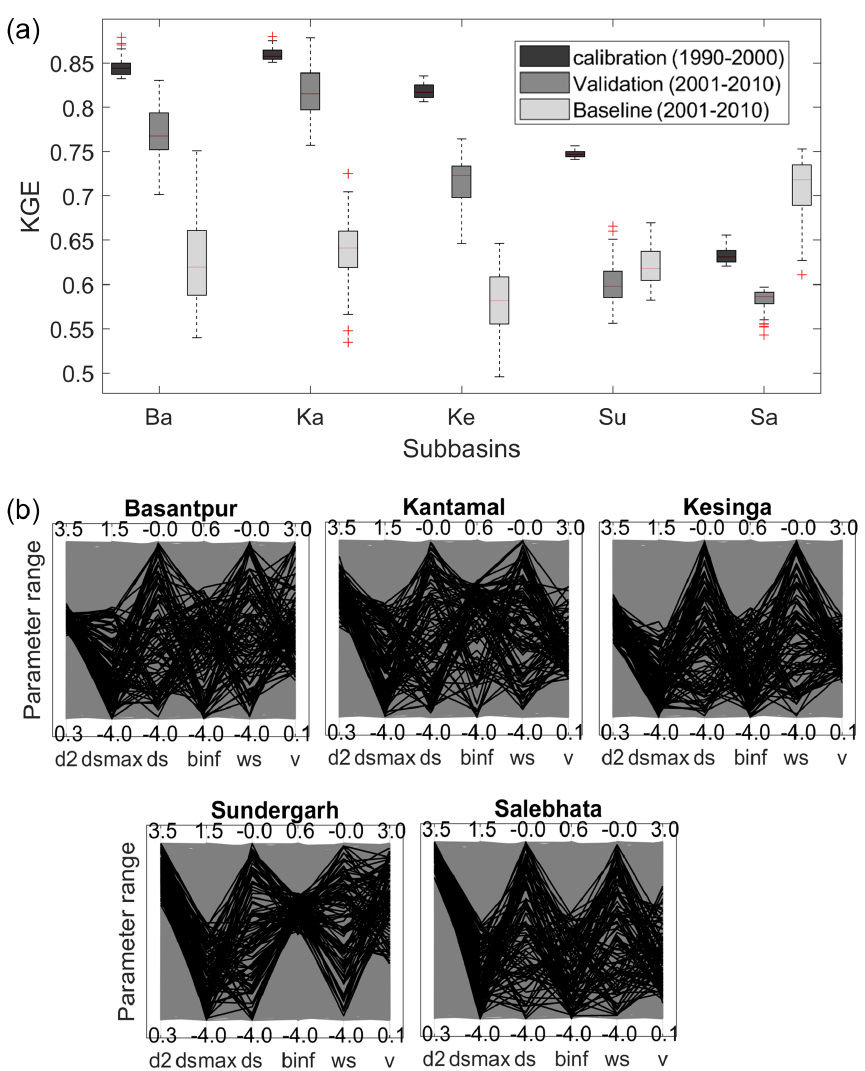
Figure 6. (a) Boxplot showing KGE range for calibrated, validated and baseline scenario simulations. (b) Parallel coordinate plot representing VIC-3L behavioural parameterization for all subcatchments obtained during model calibration. Lines in black are simulations where KGE lies within top 2% i.e., behavioural simulations, and lines in grey are non-behavioural simulations. Behavioural KGE values at Ba, Ka, Ke, Su and Sa range from 0.83–0.88, 0.85–0.88, 0.81–0.84, 0.74–0.76 and 0.62–0.66, respectively. Parameters are defined in Table